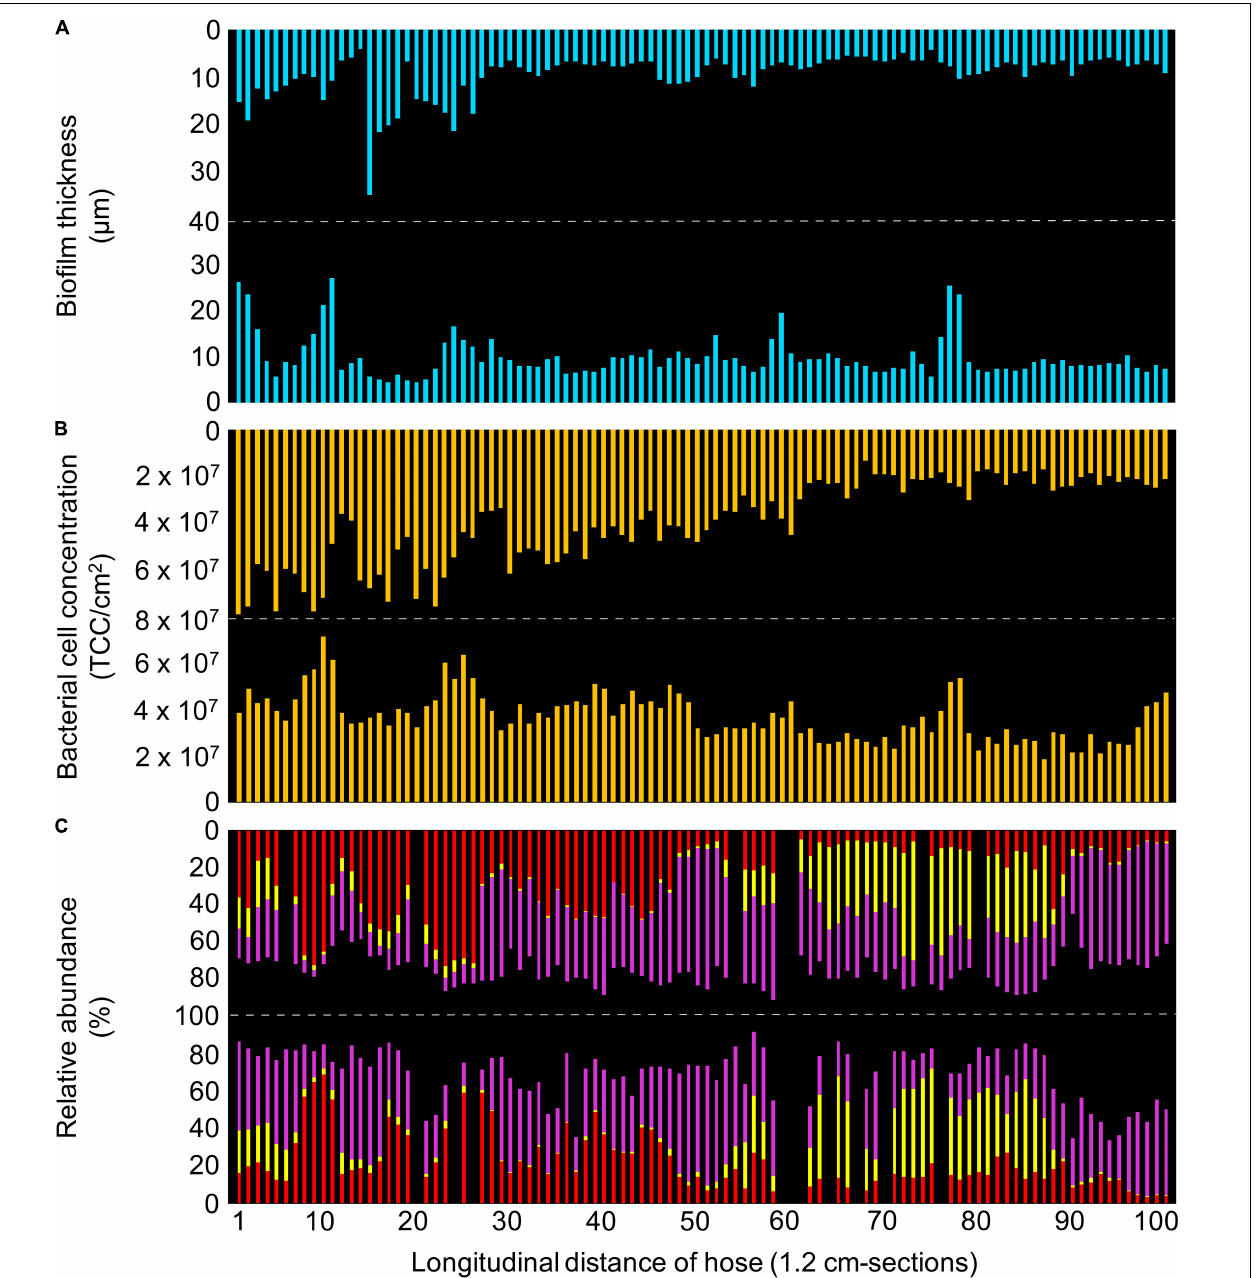
FIGURE 5 | Detailed characterization of the real hose biofilm, with bars representing individual sections of 1.2 cm. (A) Biofilm thickness measured with optical coherence tomography. (B) Bacterial cell concentrations measured with flow cytometry. (C) Community composition measured with 16S rRNA gene sequencing, showing the relative abundance of the three most abundant taxa (red: Bradyrhizobium spp.; yellow: Altererythrobacter spp.; purple: Caulobacter spp.). Data gaps resulted from insufficient DNA amplification.